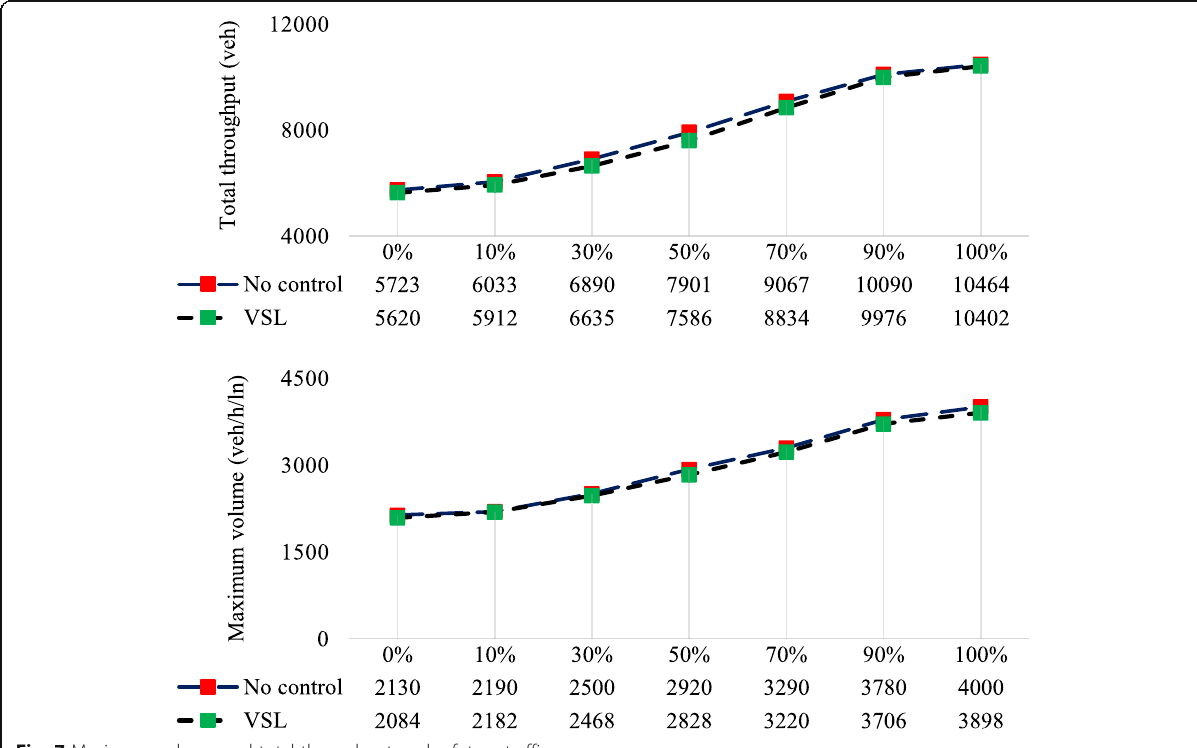
Fig. 7 Maximum volume and total throughput under future traffic